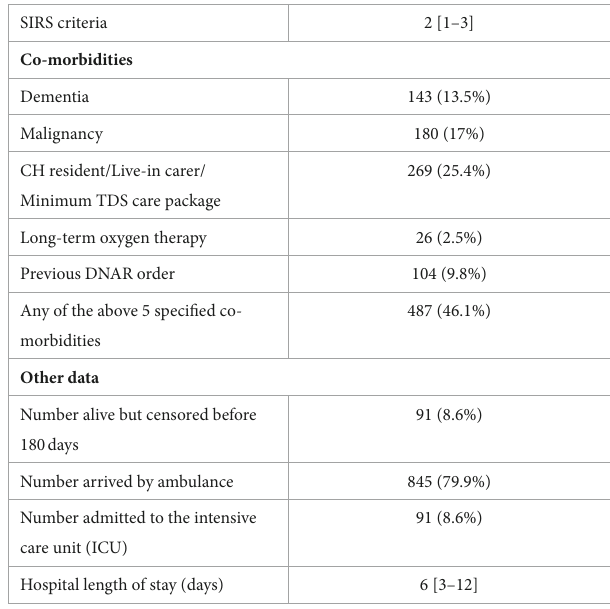
Table 2 illustrates the survival fractions in the high and low risk categories of the different stratification tools. The survival rates for the low risk group was highest for the REDS score. This was similar to the survival rate for those identified as low-risk by the Red-flag criteria. The survival rate for the low-risk group was lowest as stratified by the SIRS criteria. The REDS score and the SOFA score had the lowest survival fraction for their respective high-risk groups. All other scoring systems had similar survival fractions in their high- risk groups. The Kaplan–Meier survival curves for the study population by the different risk-stratification tools, together with the log-rank test for the difference in survival between the high and low-risk categories are illustrated in Figure 2. All risk-stratification tools except the SIRS criteria, were able to prognosticate for outcome at 180 days. The hazard ratio between high and low risk groups for the different risk- stratification tools was greatest for the REDS and the SOFA scores. The hazard ratios for the Red-flag criteria, NICE high-risk criteria and the NEWS2 scores were similar. The SIRS criteria were not prognostic for survival at 180 days with no difference in survival fractions in the high and low risk categories on log-rank test, p = 0.98, and a hazard ratio of regression of the six risk-stratification tools showed that the performance of the REDS and SOFA scores were better than the other risk-stratification tools (Table 3). The AUROC curve (Figure 3) for the REDS score for in-hospital mortality and mortality at 180 days was 0.70 (95% CI 0.67–0.72). The AUROC curve for the admission SOFA score however, decreased